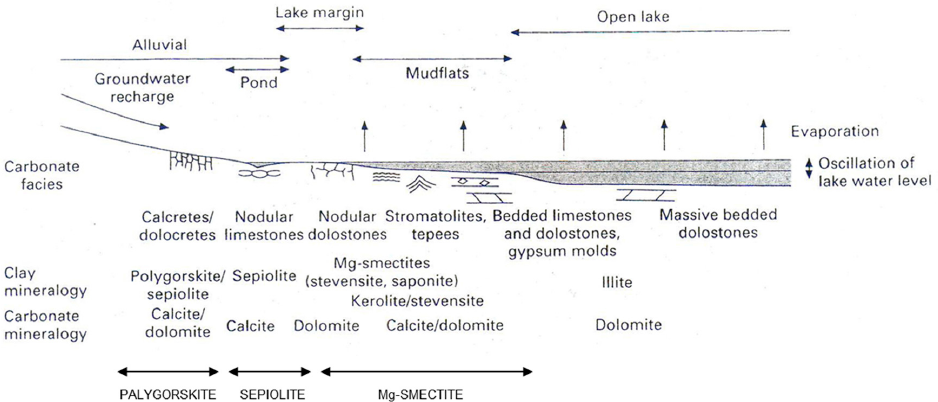
Figure 3. Idealized model showing the paleogeographic distribution of clays (mainly Mg-clays) and carbonate deposits in the Miocene formations of the Madrid Basin (modified from [59]).